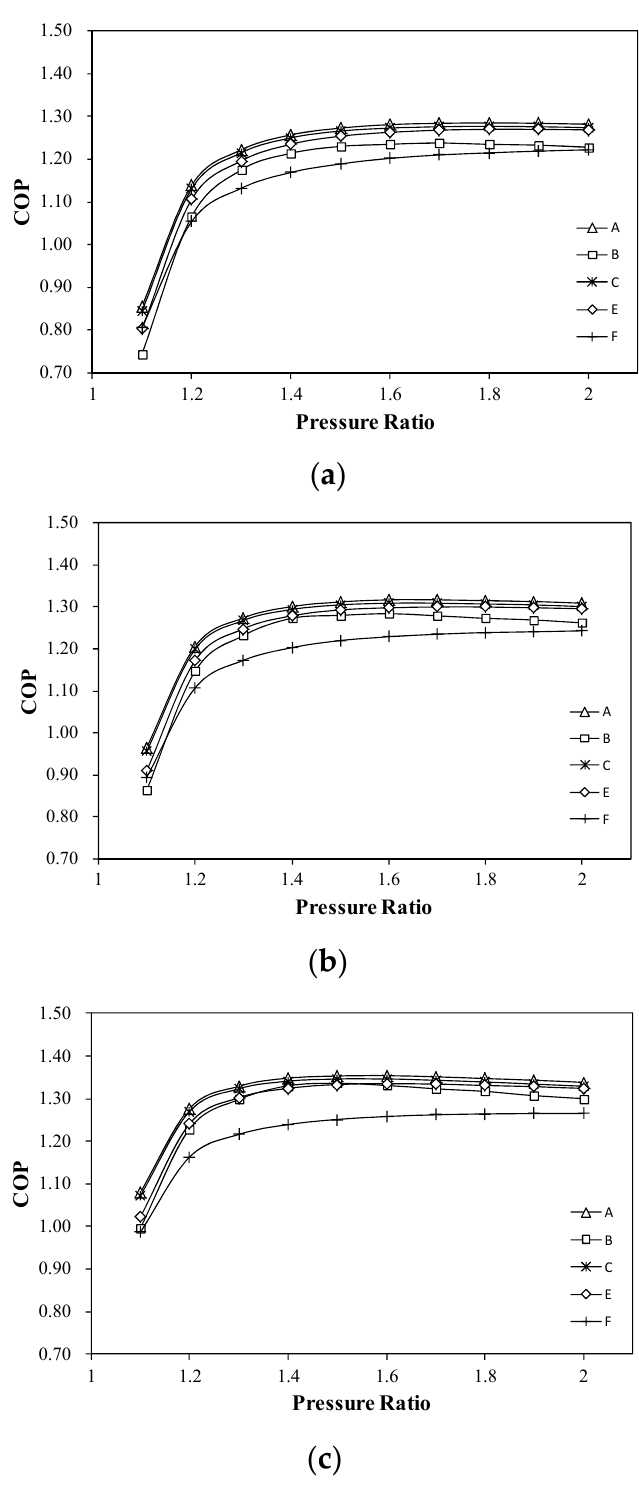
Figure 3. Variation of COP versus pressure ratio at 45 °C hot water temperature. ( a ) Ambient temperature of − 15 °C. ( b ) Ambient temperature of − 5 °C. ( c ) Ambient temperature of 5 °C.